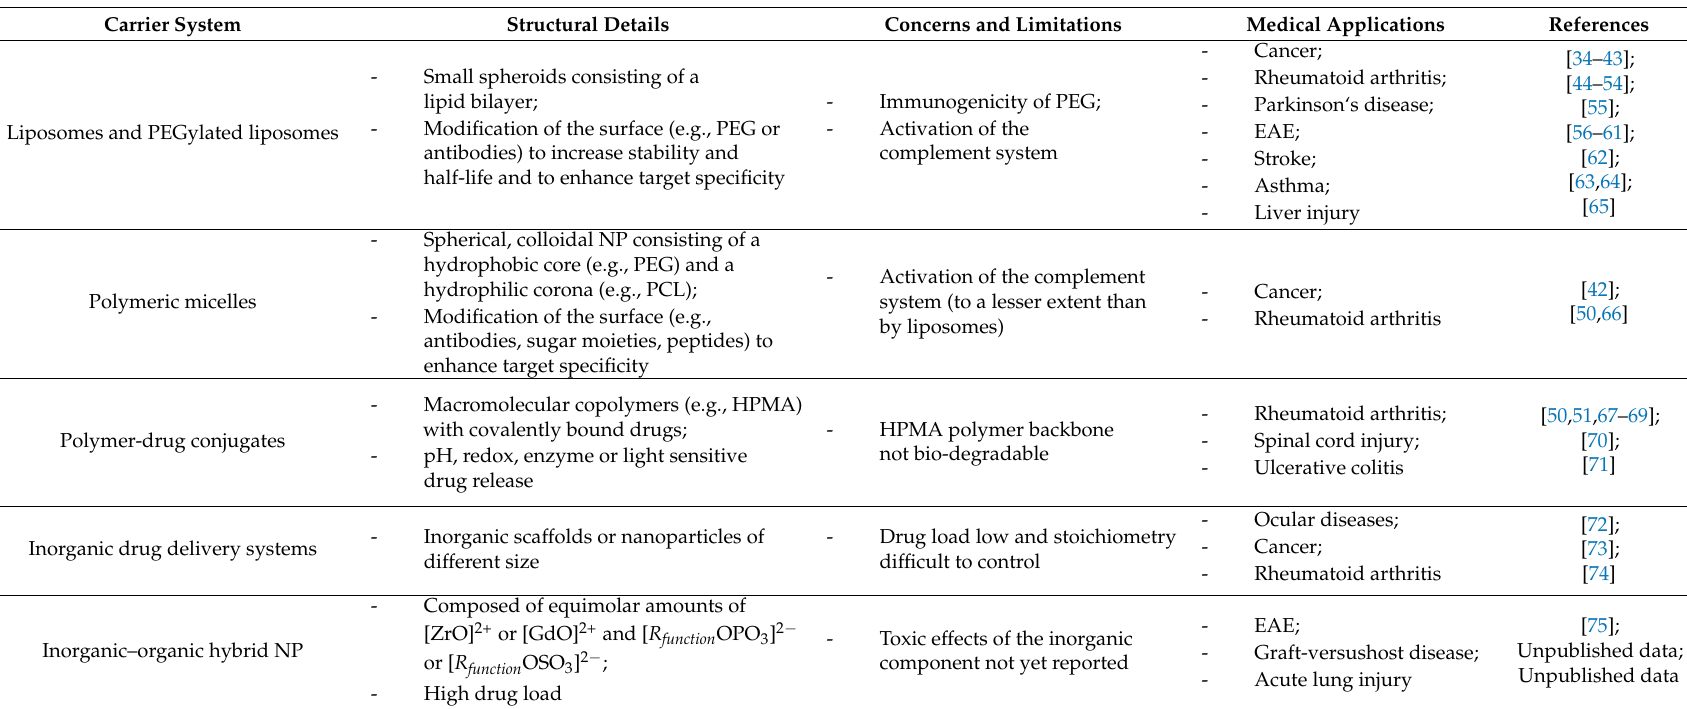
Table 1. Features and medical applications of different drug delivery systems used for GC